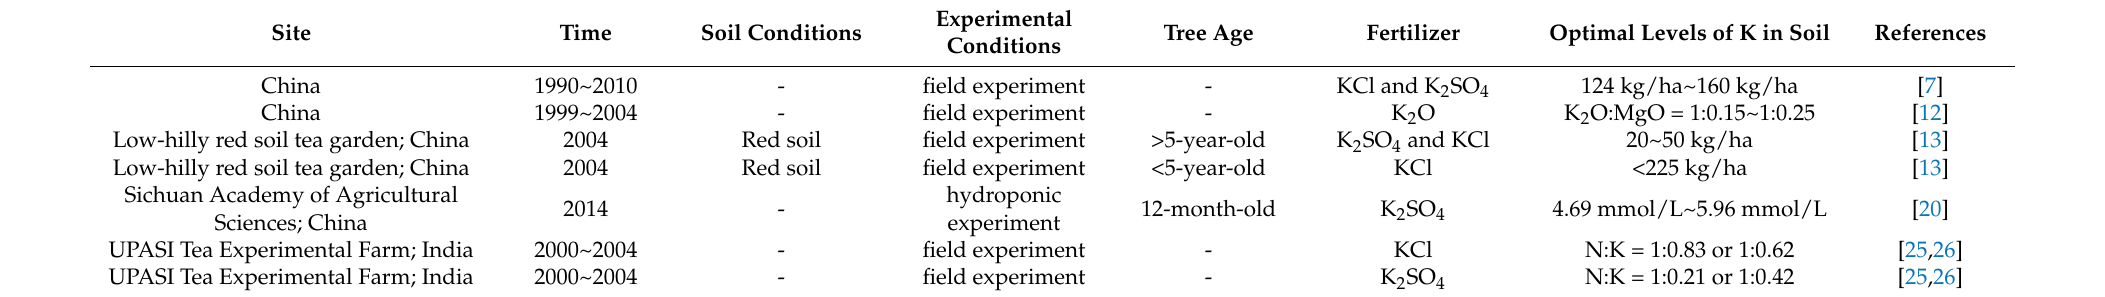
Table 3. Optimal Levels of K in Soil for Tea